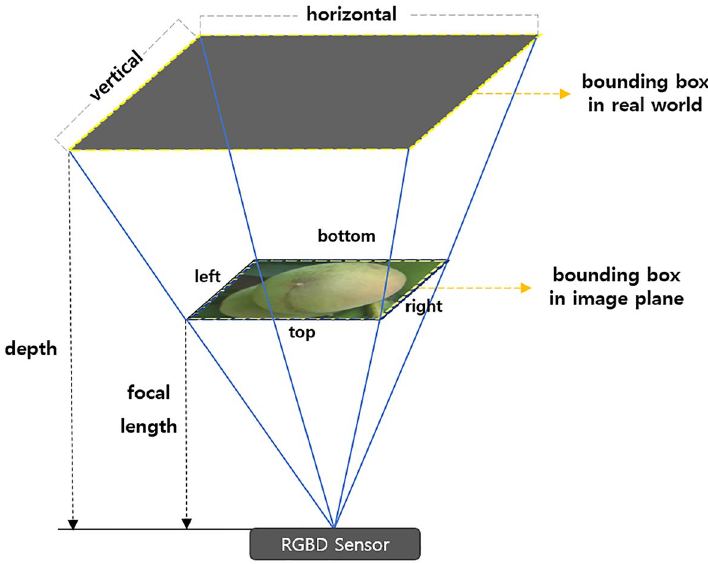
Figure 9. Calculating the diameter of prunus mume fruit using trigonometric